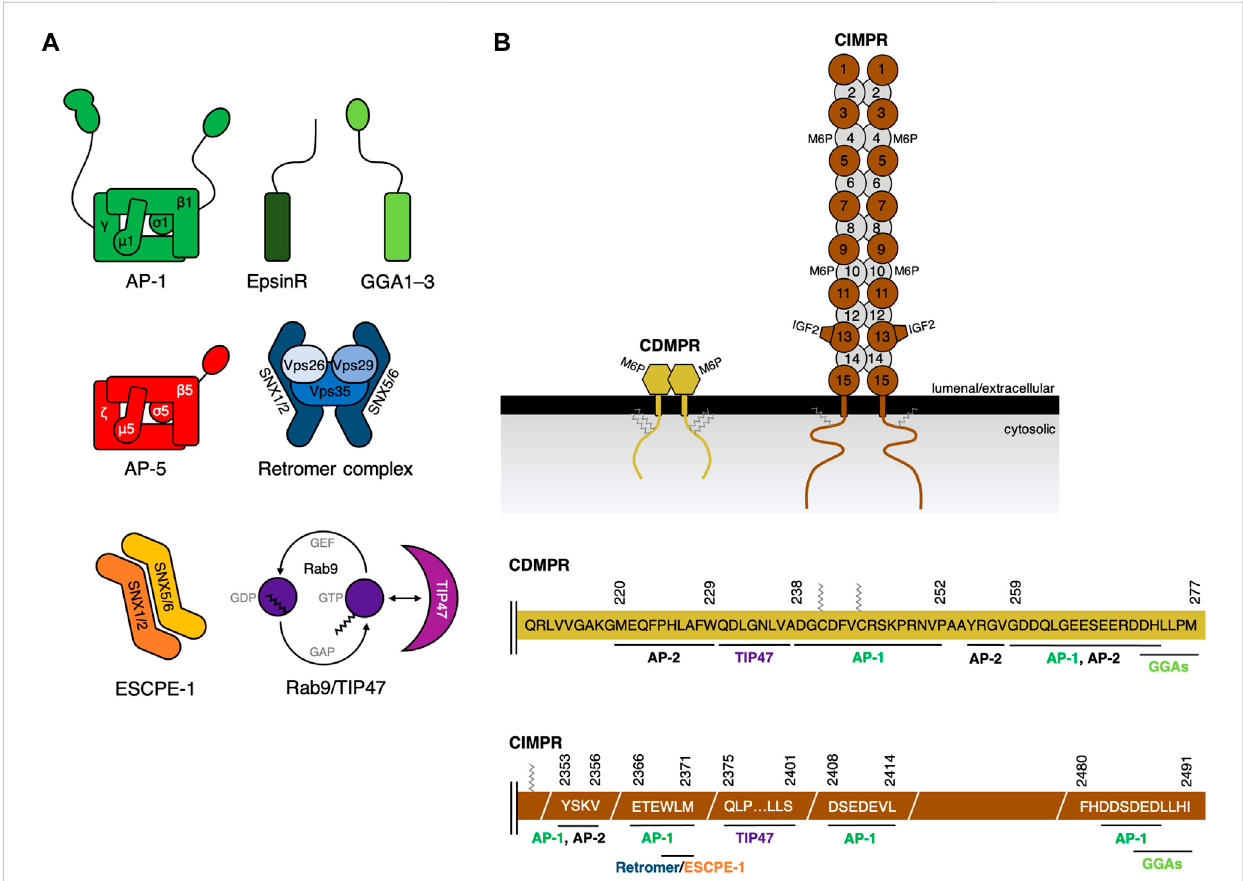
FIGURE 1 Sorting machinery proteins and cargo binding. (A) Schematic representation of sorting machinery proteins,including the clathrin adaptors (AP-1, epsinR, andGGAs),AP-5,theretromercomplex,ESCPE-1,andRab9/TIP47.Individualsubunitsareindicatedbyname.NotethatESCPE-1particularlyreferstotheSNX1/ SNX2-SNX5/SNX6 dimer. Other combinations of SNXs lead to additional ESCPE complexes. (B) Among the cargo for sorting machineries are the cation- dependent mannose-6-phosphate receptor (CDMPR) and the cation-independent mannose-6-phosphate receptor (CIMPR). Both CDMPR and CIMPR are present predominantly as stable homodimers in membranes. Both receptors have a different number of M6P-binding sites per polypeptide chain. CIMPR has further a binding site for IGF2. Both receptors can undergo various posttranslational modi fi cations (e.g., palmitoylation) that can direct the receptor ’ s traf fi ckingitinerary.AschematicrepresentationofthecytosolictailsofthehumanMPRs,showingthepredictedoridenti fi edamino-acidsortingsignalsandtheir associatedtransportproteins(sitesforAP-2arehighlightedasreferenceaswell).Theresiduesafterthetransmembrane(TM)domainofCDMPRandCIMPRare indicated.Palmitoylationsitesareindicatedingray.WhileCDMPR ’ sfullcytosolictailisdepicted,onlycriticalsitesarehighlightedforCIMPR.ThedrawnMPRtails are not proportional to each other in size. Adaptor protein complex 1/2 (AP-1/2); adaptor protein complex5 (AP-5); Golgi-localized, γ -adaptin ear-containing, ARF-bindingproteins1-3(GGA1 – 3);epsin-relatedprotein(epsinR);tail-interactingprotein47(TIP47);endosomalSNX-BARsortingcomplexforpromotingexit (ESCPE); vacuolar protein sorting (Vps) protein 26, 29, and 35 (Vps26, 29, and 35); sorting nexin (SNX); Bin/Amphiphysin/Rvs (BAR); spastic paraplegia proteins 11 and 15 (SPG11 and SPG15); Insulin-like growth factor 2 (IGF2). The MPR illustration is derived from another article (Ghosh et al.,